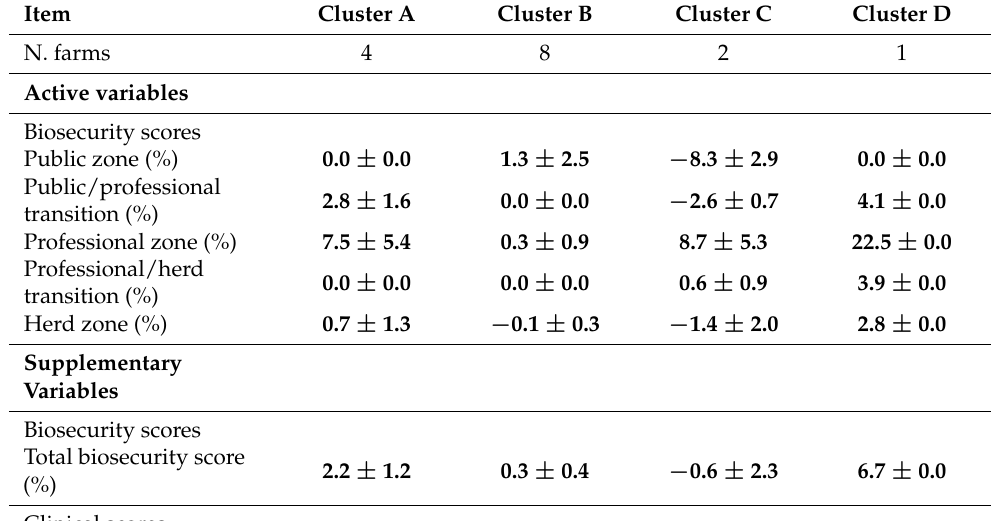
Table 4. Changes in biosecurity scores after 12 months and biomarker evolution in the four clusters identified with the HCA. Values in bold correspond to variables with a squared cosine